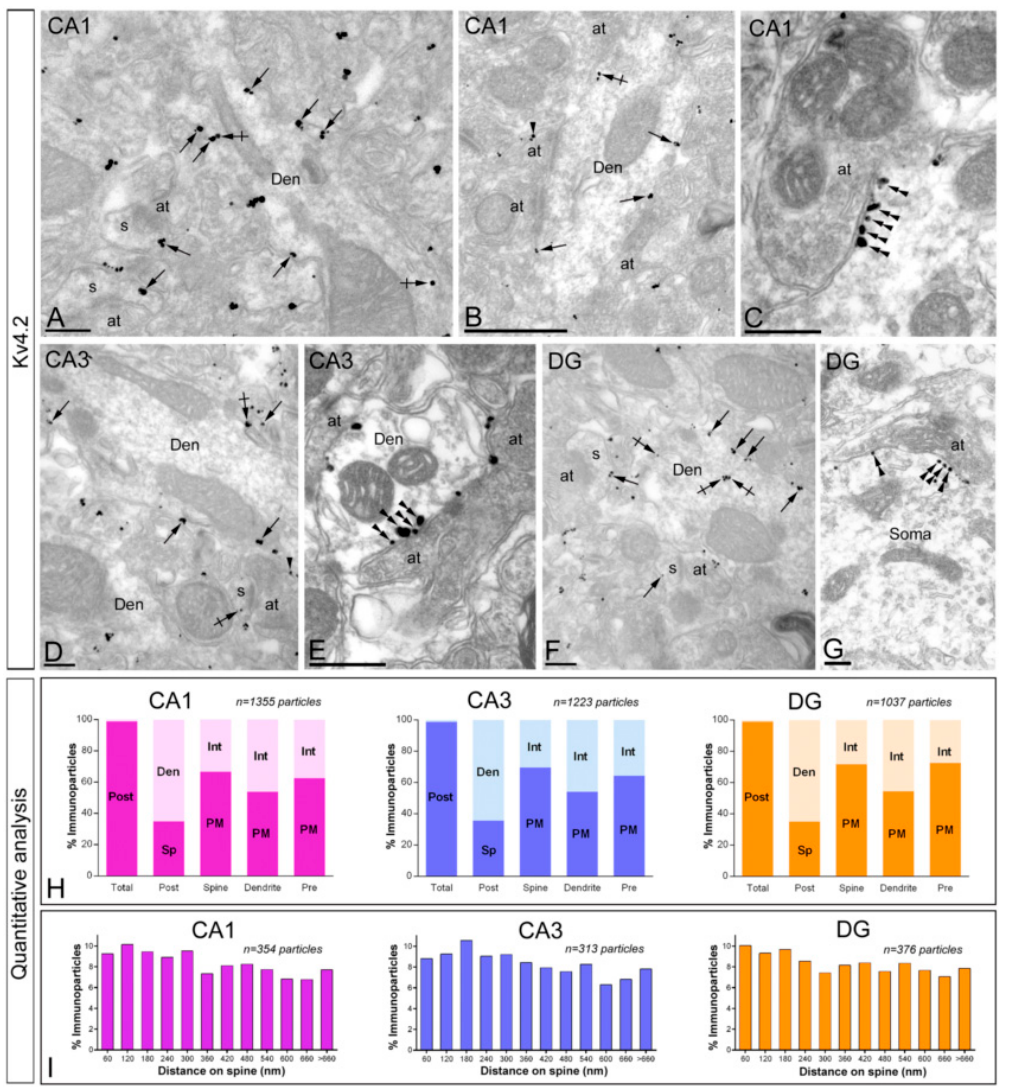
Figure 7. Subcellular localisation of Kv4.2 in the adult hippocampus. Electron micrographs showing immunoparticles for Kv4.2 in the hippocampus, as detected using the pre-embedding immunogold technique at P60. ( A – D ) Immunoreactivity for Kv4.2 was detected in similar neuronal compartments in the CA1 (panels A , B and C ) and CA3 (panels D and E ) regions and dentate gyrus (DG, panels F and G ). Kv4.2 immunoparticles were abundant along the extrasynaptic plasma membrane (arrows) of dendritic spines (s) contacted by axon terminals (at) and dendritic shafts (Den) of pyramidal cells and granule cells. Immunoparticles were also observed at intracellular sites (crossed arrows) in dendritic spines (s) and shafts (Den). Very few immunoparticles for Kv4.2 were also localised to the extrasynaptic plasma membrane (arrowheads) of axon terminals (at) establishing asymmetrical synapses with spines (s). Kv4.2 immunoparticles (double arrowheads) were detected along the main body of the postsynaptic membrane specialisation of GABAergic synapses in the CA1 (panel C ), CA3 (panel E ) and DG (panel G ); ( H ) Compartmentalisation of Kv4.2 in CA1 pyramidal cells, CA3 pyramidal cells and DG granule cells. Bar graphs showing the percentage of immunoparticles for Kv4.2 at post- and presynaptic compartments, and along the plasma membrane and intracellular sites in dendritic spines, dendritic shafts and axon terminals. A total of 1355 immunoparticles in the CA1, 1223 in the CA3 and 1037 in the DG were analysed. Most immunoparticles were postsynaptic, both along the plasma membrane and at cytoplasmic sites. Postsynaptically, immunoparticles were detected in dendritic spines and in